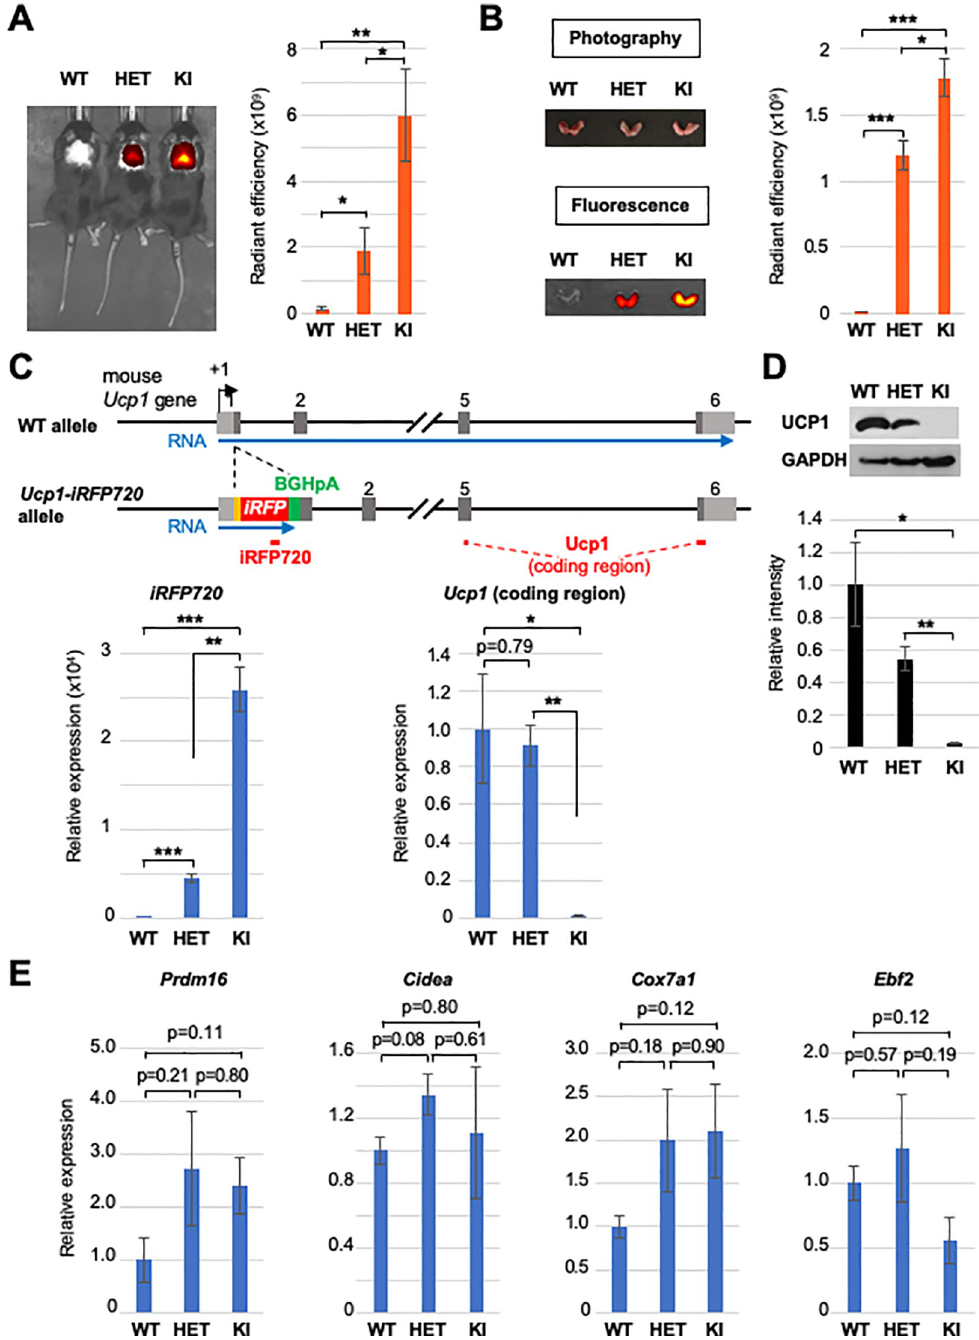
Fig 3. In vivo imaging of BAT in Ucp1-iRFP720 KI mice. (A) In vivo imaging of the BATs of WT, heterozygous Ucp1-iRFP720 KI (HET) and homozygous Ucp1-iRFP720 KI mice (KI). Quantified fluorescence intensity for each mouse is shown in the bar graph (n = 4). �� p < 0.01, � p < 0.05 (B) BATs isolated from the mice used in Fig 3A. Fluorescence image of the BATs is shown in the lower panel. Quantified fluorescence intensity is shown in the bar graph (n = 4). ��� p < 0.001, � p < 0.05 (C) Quantitative RT-PCR analysis of the iRFP720 and Ucp1 (coding region) in WT mice, heterozygous Ucp1-iRFP720 KI mice and homozygous Ucp1-iRFP720 KI mice (n = 3). The positions of the amplicons are shown as red bars. ��� p < 0.001, �� p < 0.01, � p < 0.05 (D) Expression of UCP1 in the Ucp1-iRFP720 KI mice determined by immunoblot. GAPDH was used as a loading control. The bar graph shows the quantified intensities of UCP1 bands in the immunoblot (n = 3). �� p < 0.01, � p < 0.05 (E) Quantitative RT-PCR analysis of the brown adipocyte marker genes in WT mice, heterozygous Ucp1-iRFP720 KI mice and homozygous Ucp1-iRFP720 KI mice (n = 3).